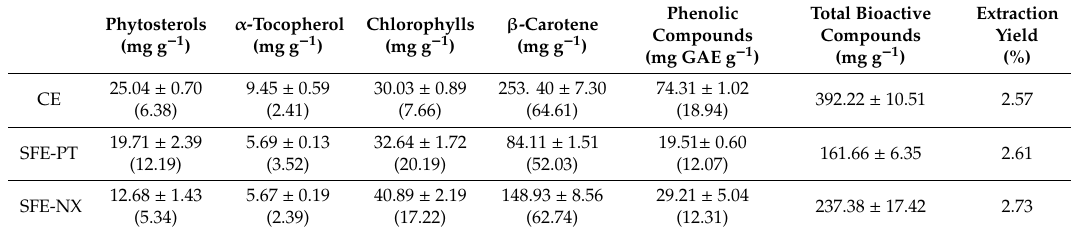
Table 3. Major bioactive compounds, total bioactive compounds and extraction yield in the conventional extracts (CE) and in the optimized SFE extracts from Parthenon (SFE-PT) and Naxos (SFE-NX) by-products. The data in parenthesis represent the proportion of each type of compound with respect to the total bioactive compounds, expressed as %. Values are given as the mean ± SD of three